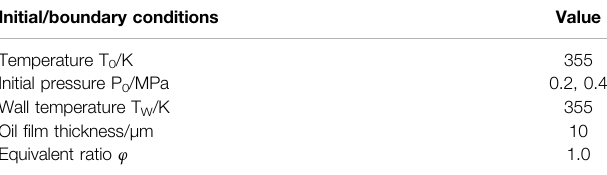
TABLE 3 | CONVERGE models used in the